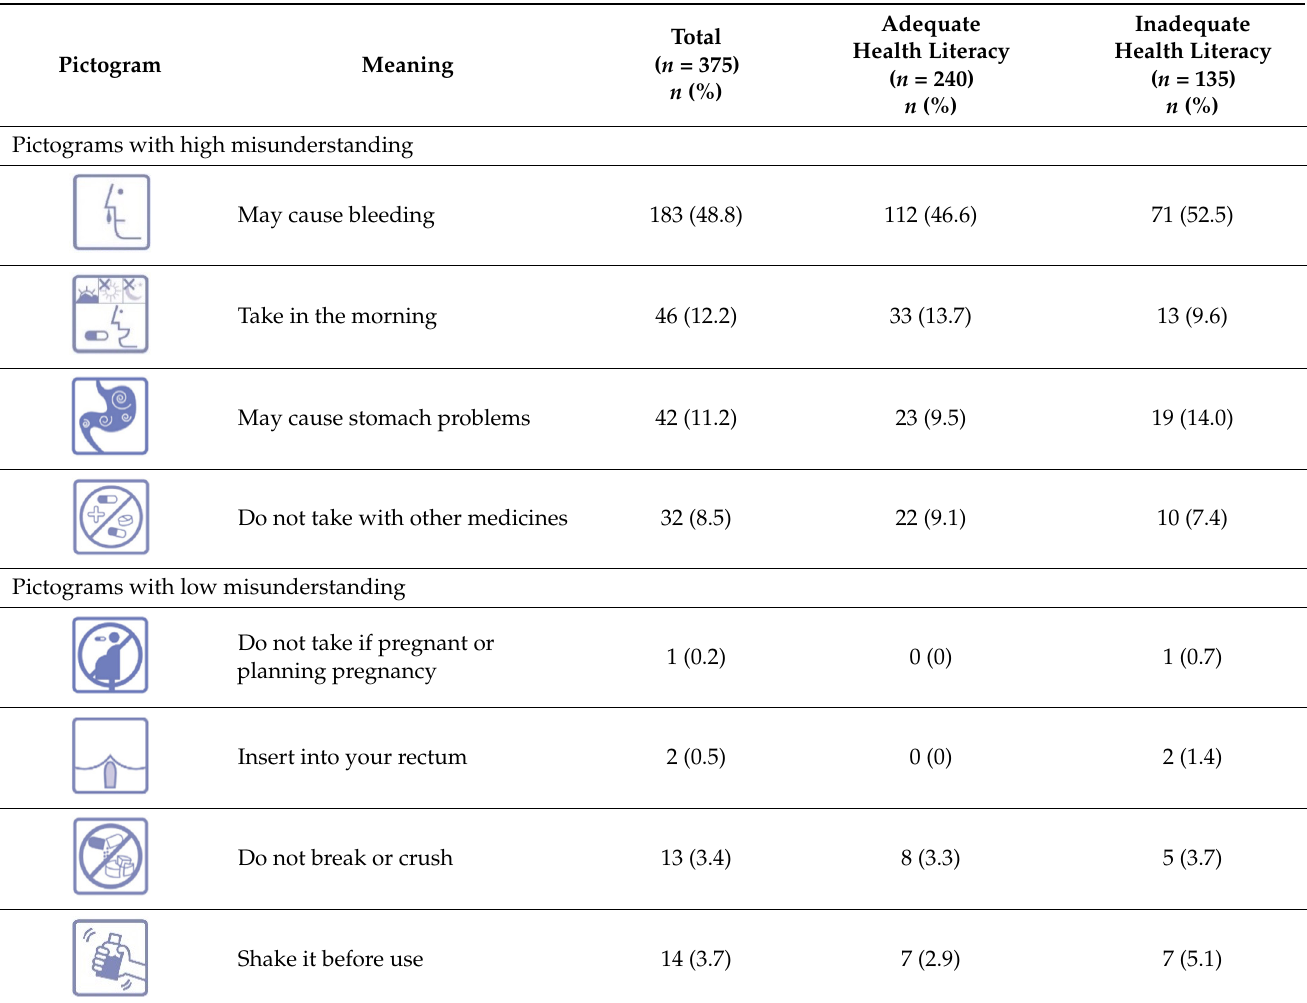
Table 4. Proportion of participants misunderstanding medication pictograms.